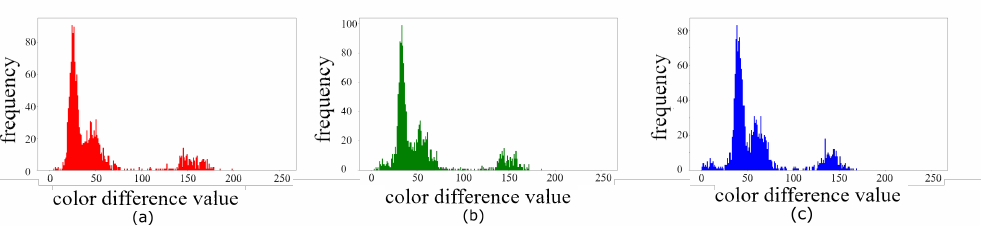
Figure 2. The distributions of the absolute stitching c-color, c ∈ {R, G, B}, difference values of Figure 1b. ( a ) For R-color. ( b ) For G-color. ( c ) For